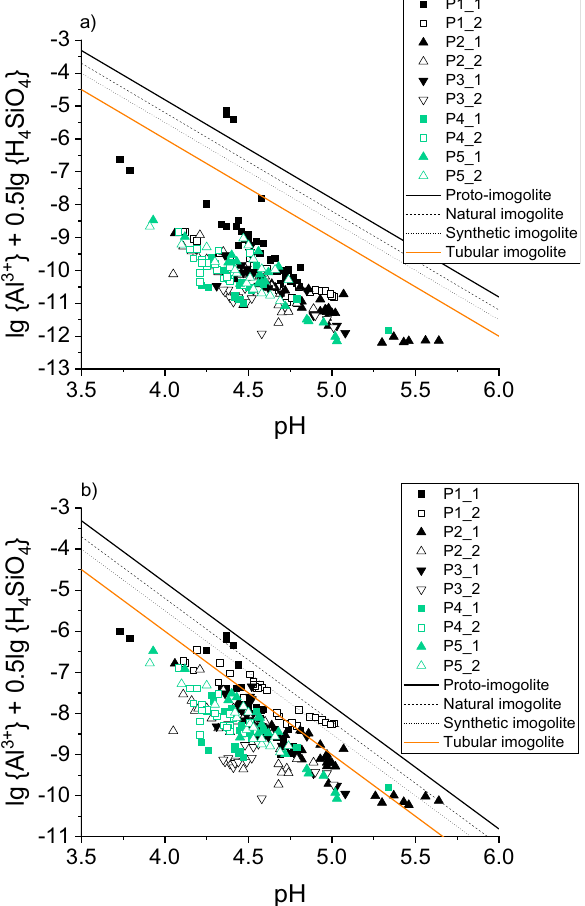
Figure 7. Activities of dissolved Al 3+ and H 4 SiO 4 plotted against pH, calculated with ( a ) citric or ( b ) acetic acid as a model of DOM. Lines result from the solubility equation for different types of imogolite 40 , lg {Al 3+ } + 0.5lg {H 4 SiO 4 } + 3pH = lg * K so . Logarithmic equilibrium constants * K so (at 298 K) were 7.19 for proto-imogolite 40 , 6.8 for natural imogolite, 6.5 for synthetic imogolite 44 , and 6.0 for tubular imogolite 45